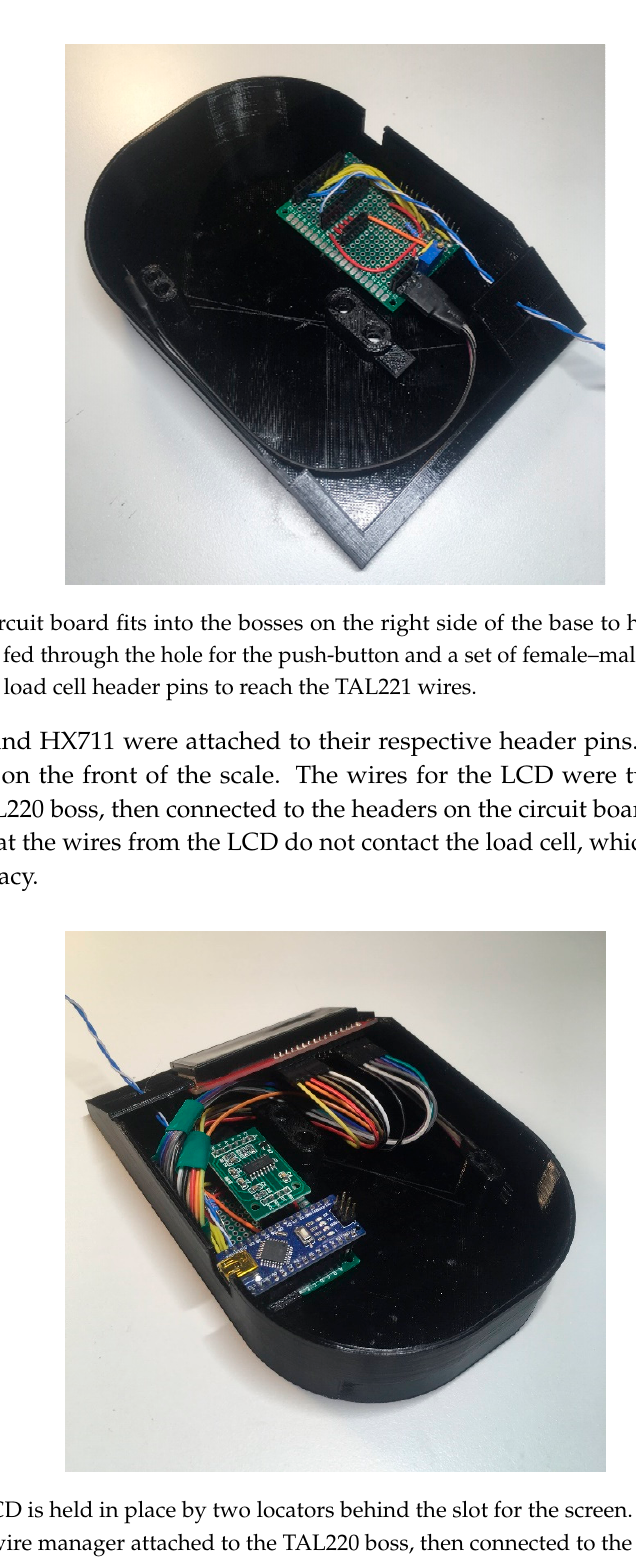
Figure 4. Key features of the base include standoffs to mount the load cell, locators for the screen and circuit board, and a slot for access to the Arduino Nano’s USB port. The base also has a snap-seam to attach the cover to the base, enclosing the internal components.